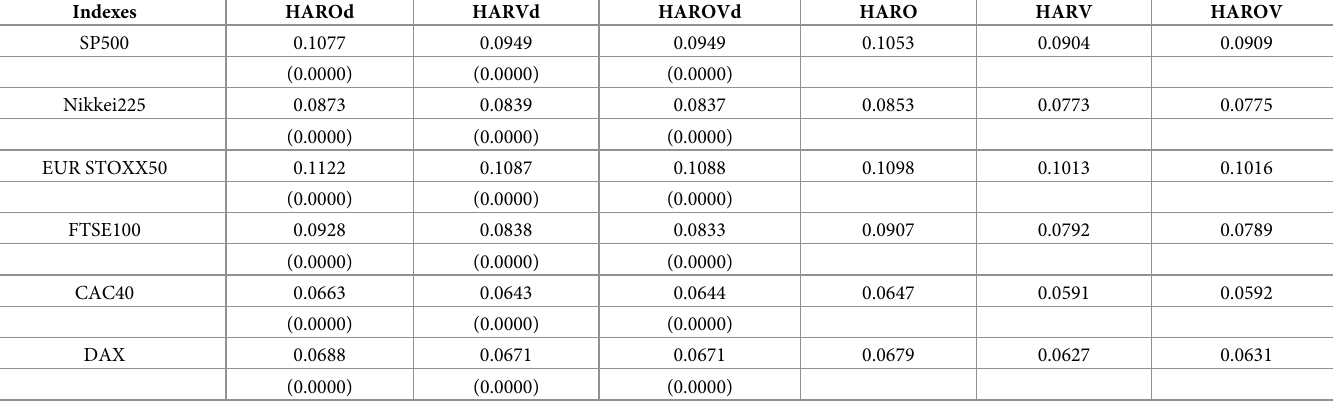
Table 4. MSFE(HAROd), MSFE(HARVd), MSFE(HAROVd) and MSFE(HARO), MSFE(HARV), MSFE(HAROV) along with the p-values of corresponding hypoth- esis tests.